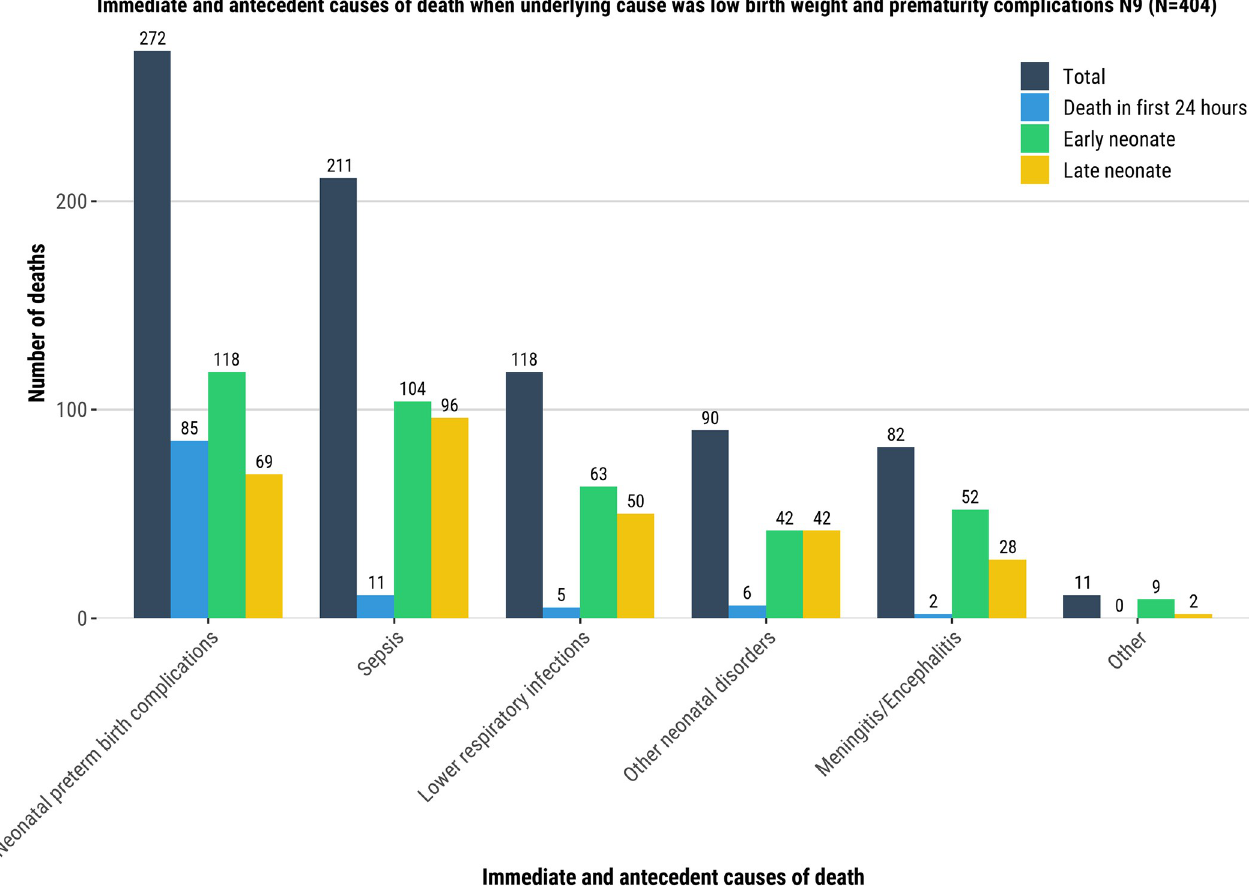
Fig 7. Immediate and antecedent causes of death when underlying cause was low birth weight and prematurity complications N9 (N = 404). Immediate and antecedent causes of